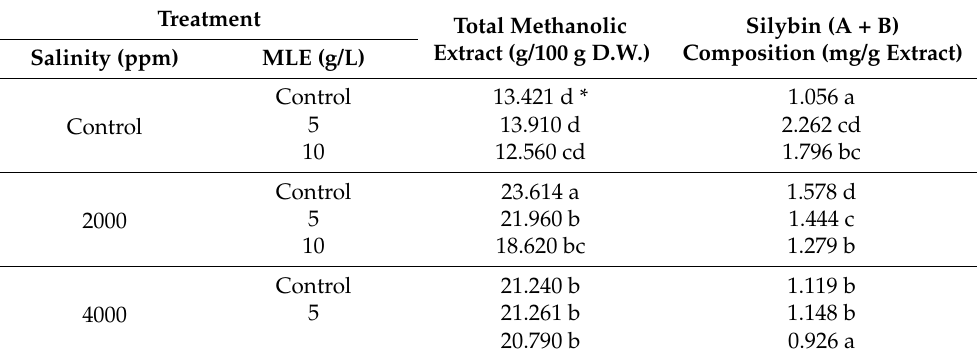
Table 8. Effects of the interactions of salinity levels and Moringa oleifera leaf extract (MLE) concentra- tions on the total amount of methanolic extracts (grams per 100 g of fruits in dry weight) and silybin (A + B) compositions (milligrams per gram of extract) from S. marianum fruit samples during the 2018 planting season.